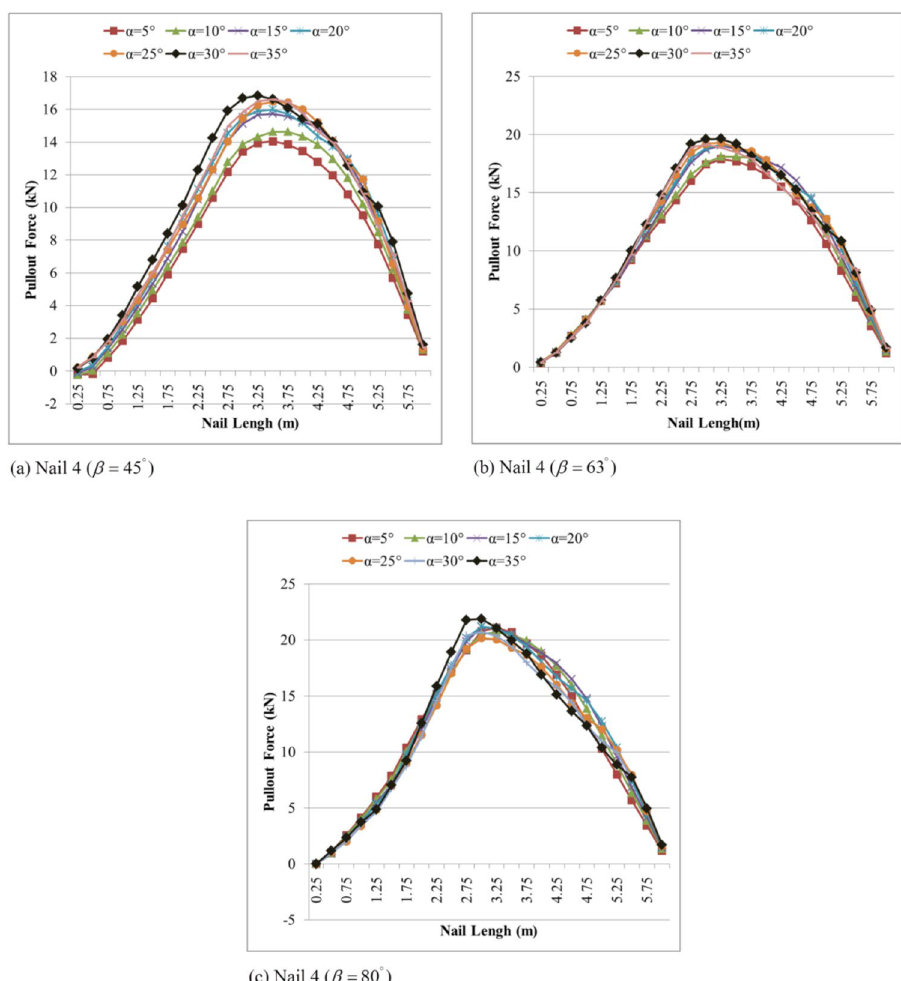
Fig. 10 Plot of the pull-out force along the length of the fourth nail at different angles of installation of slopes (45°, 63°, and 80°)